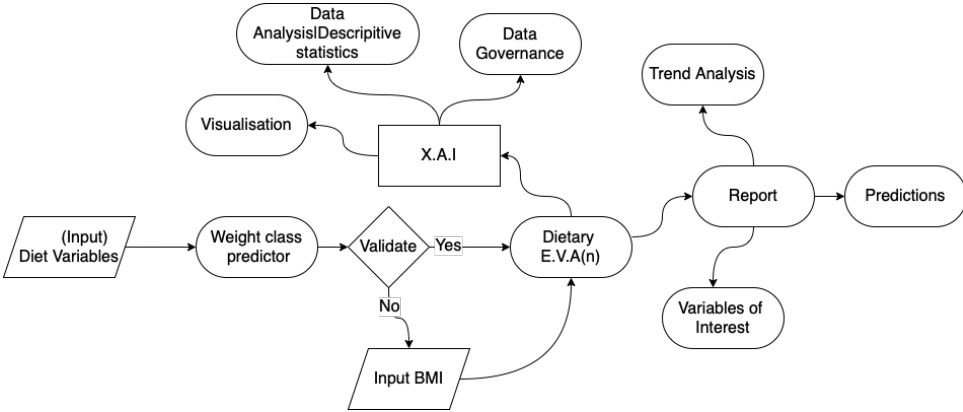
Figure 5. EVA process